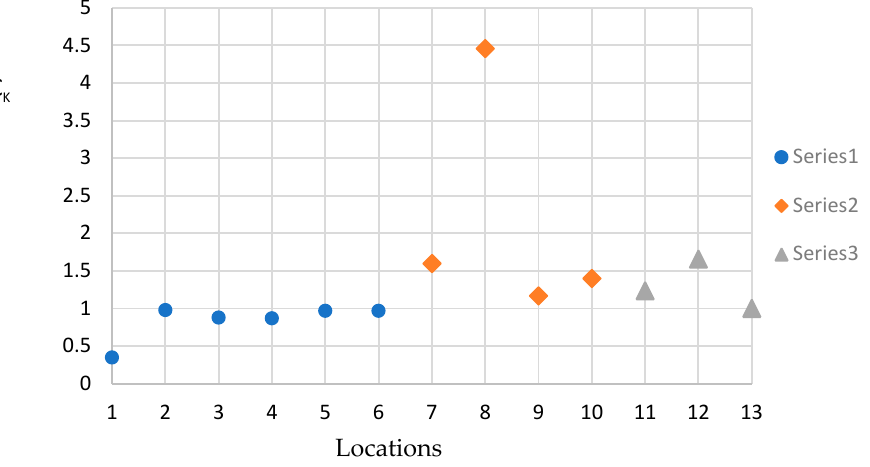
Figure 21. Quotient between entropies of meteorological variables and pollutant, C K for cities in Cuenca (Series 1), Mountain (Series 2) and Coast (Series 3).